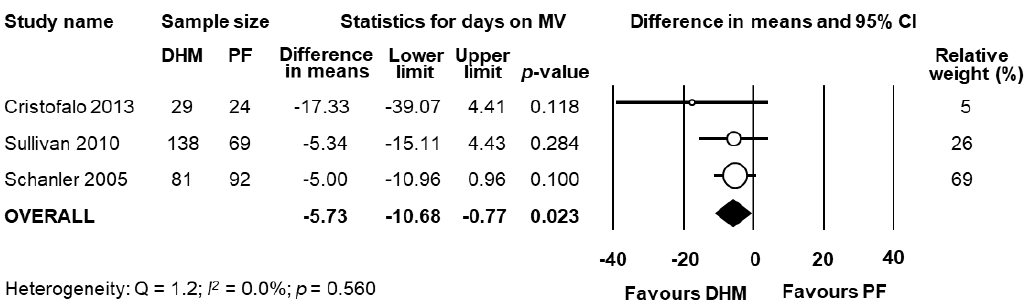
Figure 3. Meta-analysis of randomized controlled trials assessing the effects of supplementation of MOM with DHM, compared with supplementation with PF, on mean days on MV. Circles (O) represent the effect sizes per study, and their size represents the relative weight of the study in the meta-analysis. Diamonds ( ◆ ) represent the pooled effect size. DHM: donor human milk; PF: preterm formula; MV: mechanical ventilation.